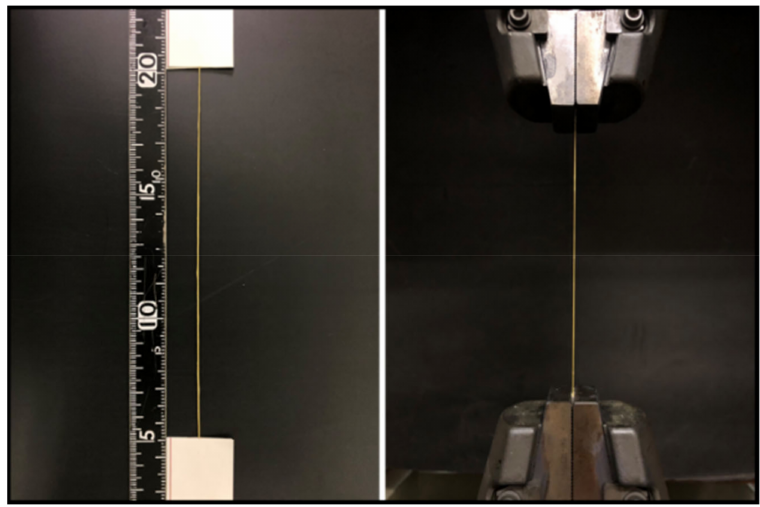
Figure 3. Determining the tensile mechanical properties of the Kevlar